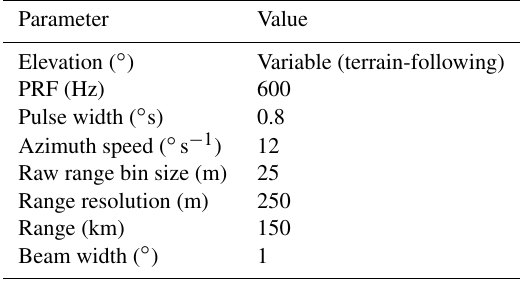
Table A1. The scan parameterization of the operational precipita- tion (PCP) scan.